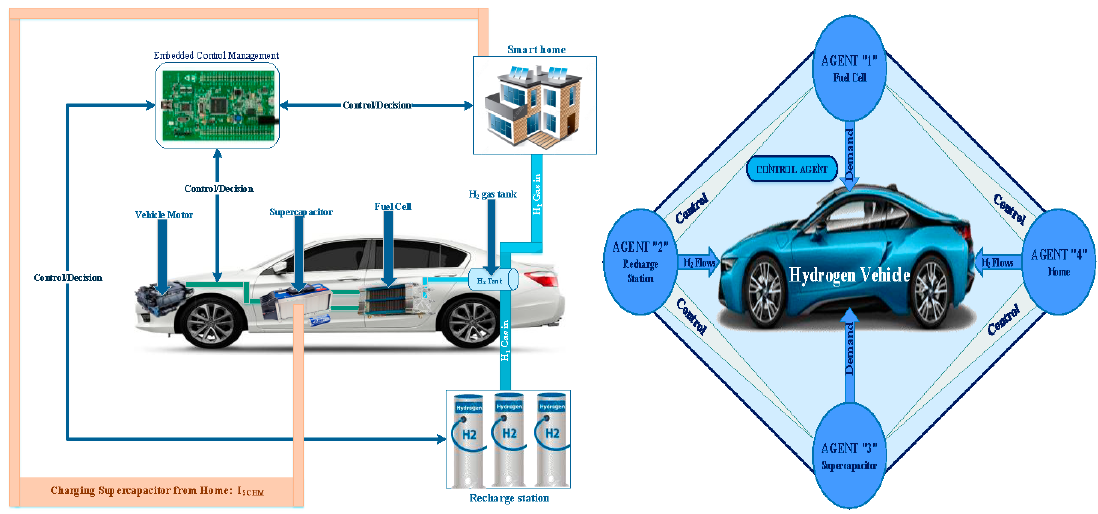
Figure 1. Overall proposed NZE-HEVSim tool.